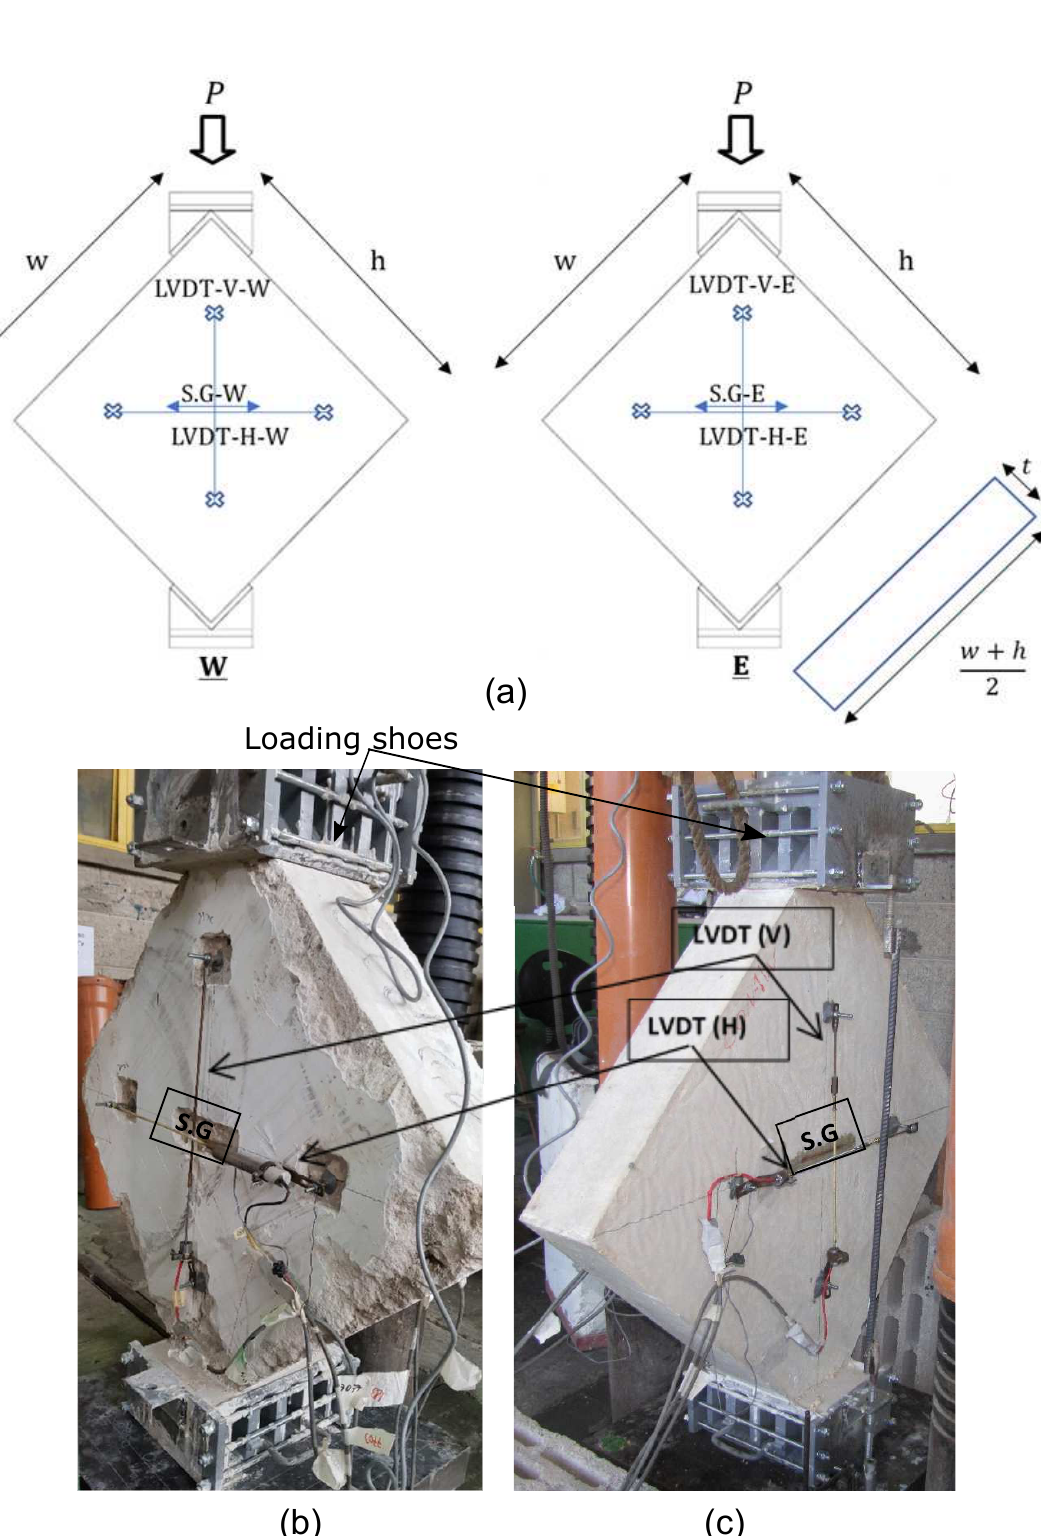
Figure 3. Diagonal compression tests: ( a ) specimens’ details and location of displacement and strain measurement devices, ( b ) authentic, and ( c ) standard concrete